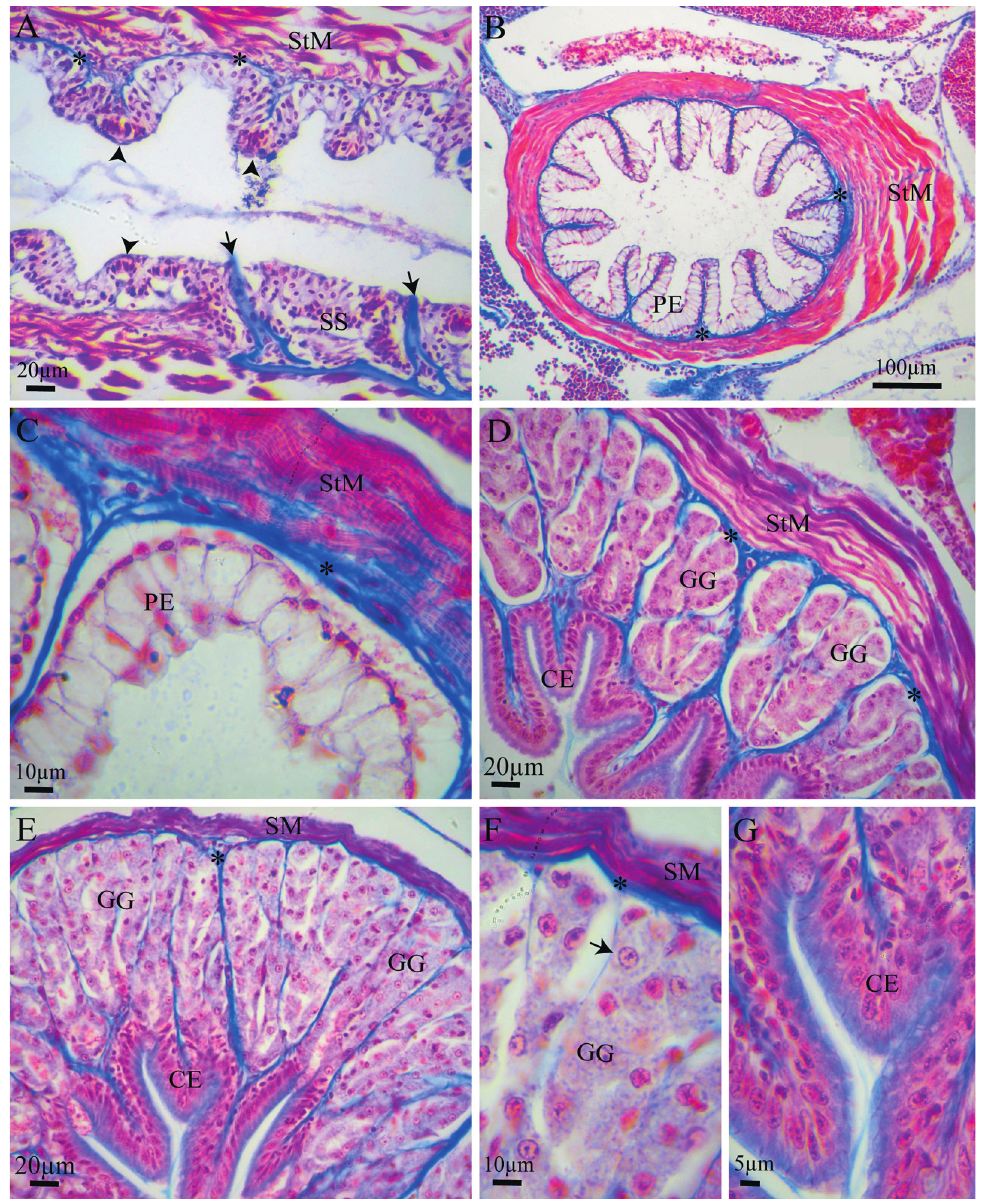
FIGURE 2 | Histological sections of the digestive tract of Paracheirodon axelrodi, stained with Masson Trichrome. A. Longitudinal section of pharynx, showing a mucosa with a stratified squamous epithelium (SS) and underneath this, a layer of loose connective tissue and a thin inner circular layer and an outer longitudinal layer of striated muscle (StM). Pharyngeal teeth (arrows) and taste buds (arrowheads) were observed. B. Cross section of the esophageal mucosa with multiple foldings, composed by a pseudostratified epithelium (PE) and abundant mucous cells. A layer of loose connective tissue was observed, surrounded by a muscular tunica with an inner longitudinal and an external circular layer of StM. C. Detail of B showing pseudostratified epithelium (PE) with abundant mucous cells, a dense septum of connective tissue and external circular layer of StM. D. Transverse section of the first portion of the stomach. where a simple columnar epithelium (CE) formed by a layer of secreting mucus cells, short gastric glands (GG) and a circular layer of StM are observed. E. Transverse section of the fundic stomach which presents a simple columnar epithelium (CE) and long ramified gastric glands (GG) surrounded by a loose connective tissue. The muscular layer at this point contained two sublayers of smooth muscle (SM), a circular inner layer and an outer longitudinal layer. F. Detail of E showing GG composed by oxintopeptics cells (black arrow). G. Detail of E showing CE as a layer of secreting mucus cells. Asterisk, loose connective tissue; CE, simple columnar epithelium; GG, gastric glands; PE, pseudostratified epithelium; SM, smooth muscle; StM, striated